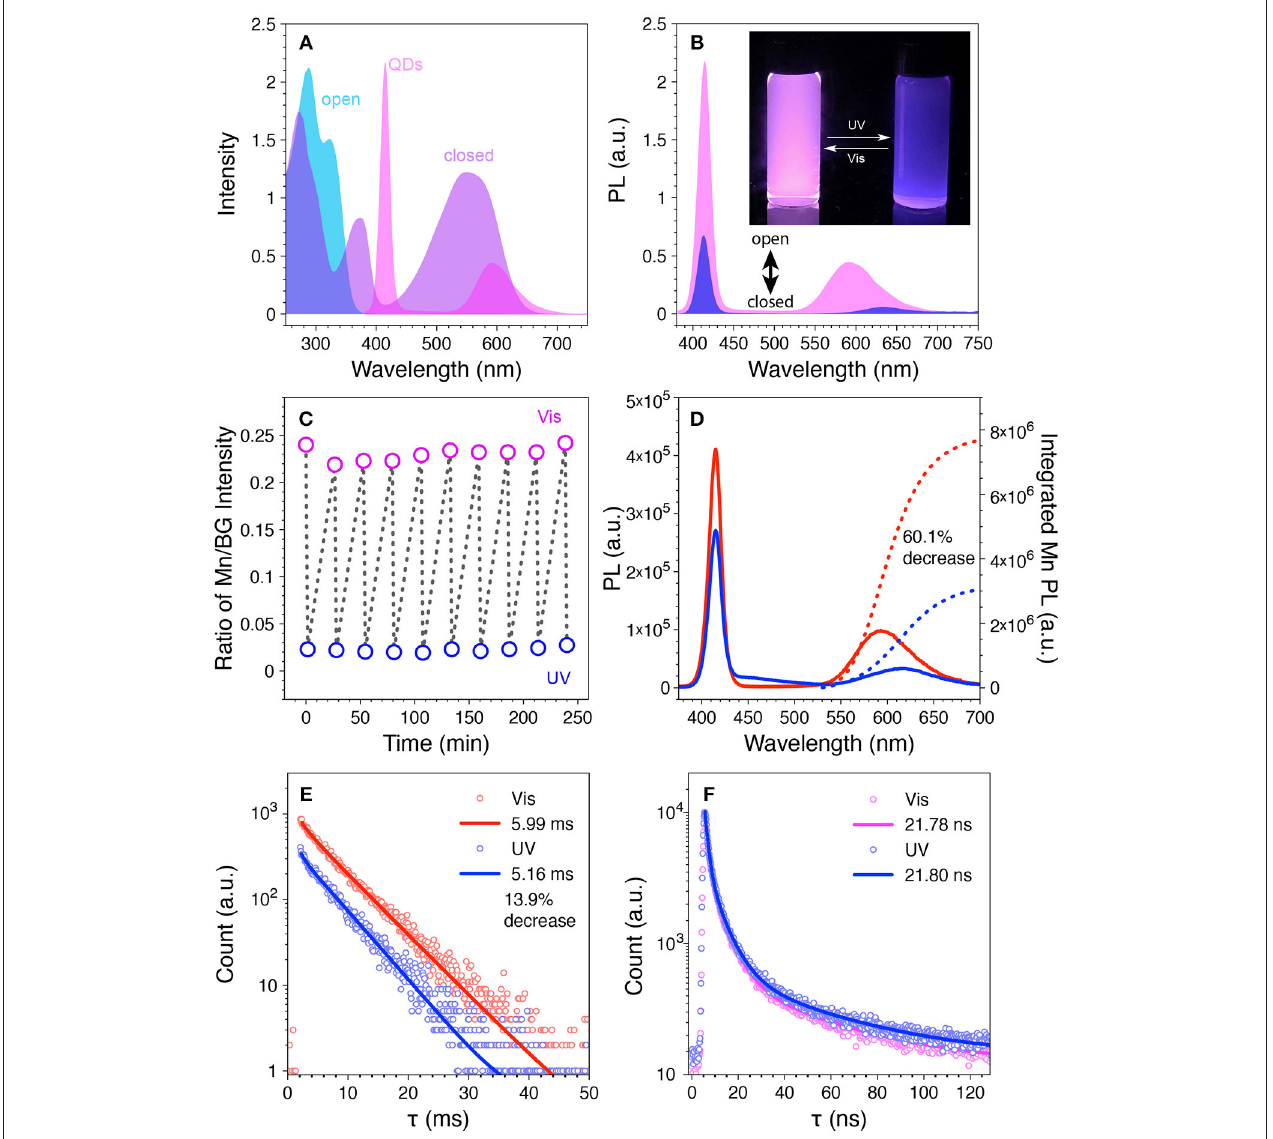
FIGURE 4 | (A) Overlay of the PL spectrum of the Mn-doped CdS-ZnS QDs with the absorption spectra of the 1o and 1c . (B) PL spectra of the mixture of Mn-doped CdS-ZnS QDs with 1o (pink) and 1c (blue). Inset: photograph for the mixture solution under UV light after UV (right) and visible (left) light illumination. (C) The ratio of Mn/BG-PL intensity during repetitive switching cycles with sequential UV (blue open circle) and visible (pink open circle) light illumination. (D) The PL intensity (solid lines) and integrated Mn-PL intensity (dotted lines) and (E) the corresponding Mn-PL lifetime changes during one switching cycle. (F) BG-PL lifetime decays after UV (blue) and visible (pink) light